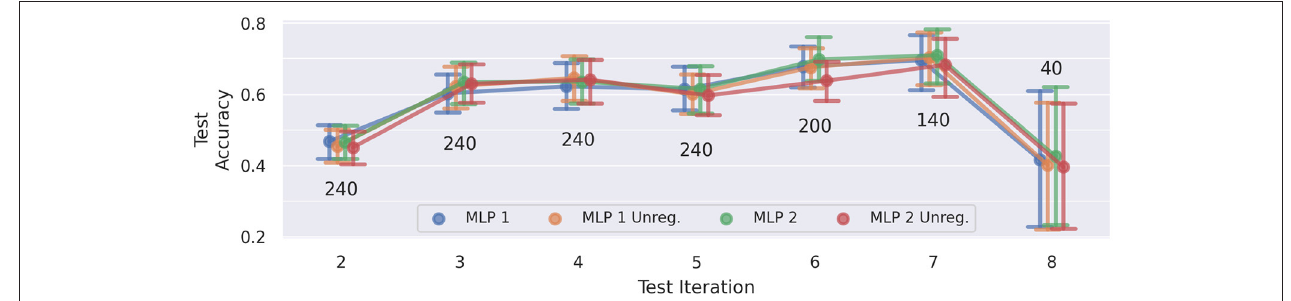
FIGURE 10 | Cross-iteration prediction accuracies: a network model trained on the data of a single iteration was evaluated on the data of the subsequent iteration. Each data point of the plot represents an average across five training runs and five subjects (A–E). The number above/below a point denotes how many training runs contribute to the computed average. Error bars indicate the 95% confidence interval. Except iteration 8, accuracies increase over time, indicating a convergence of